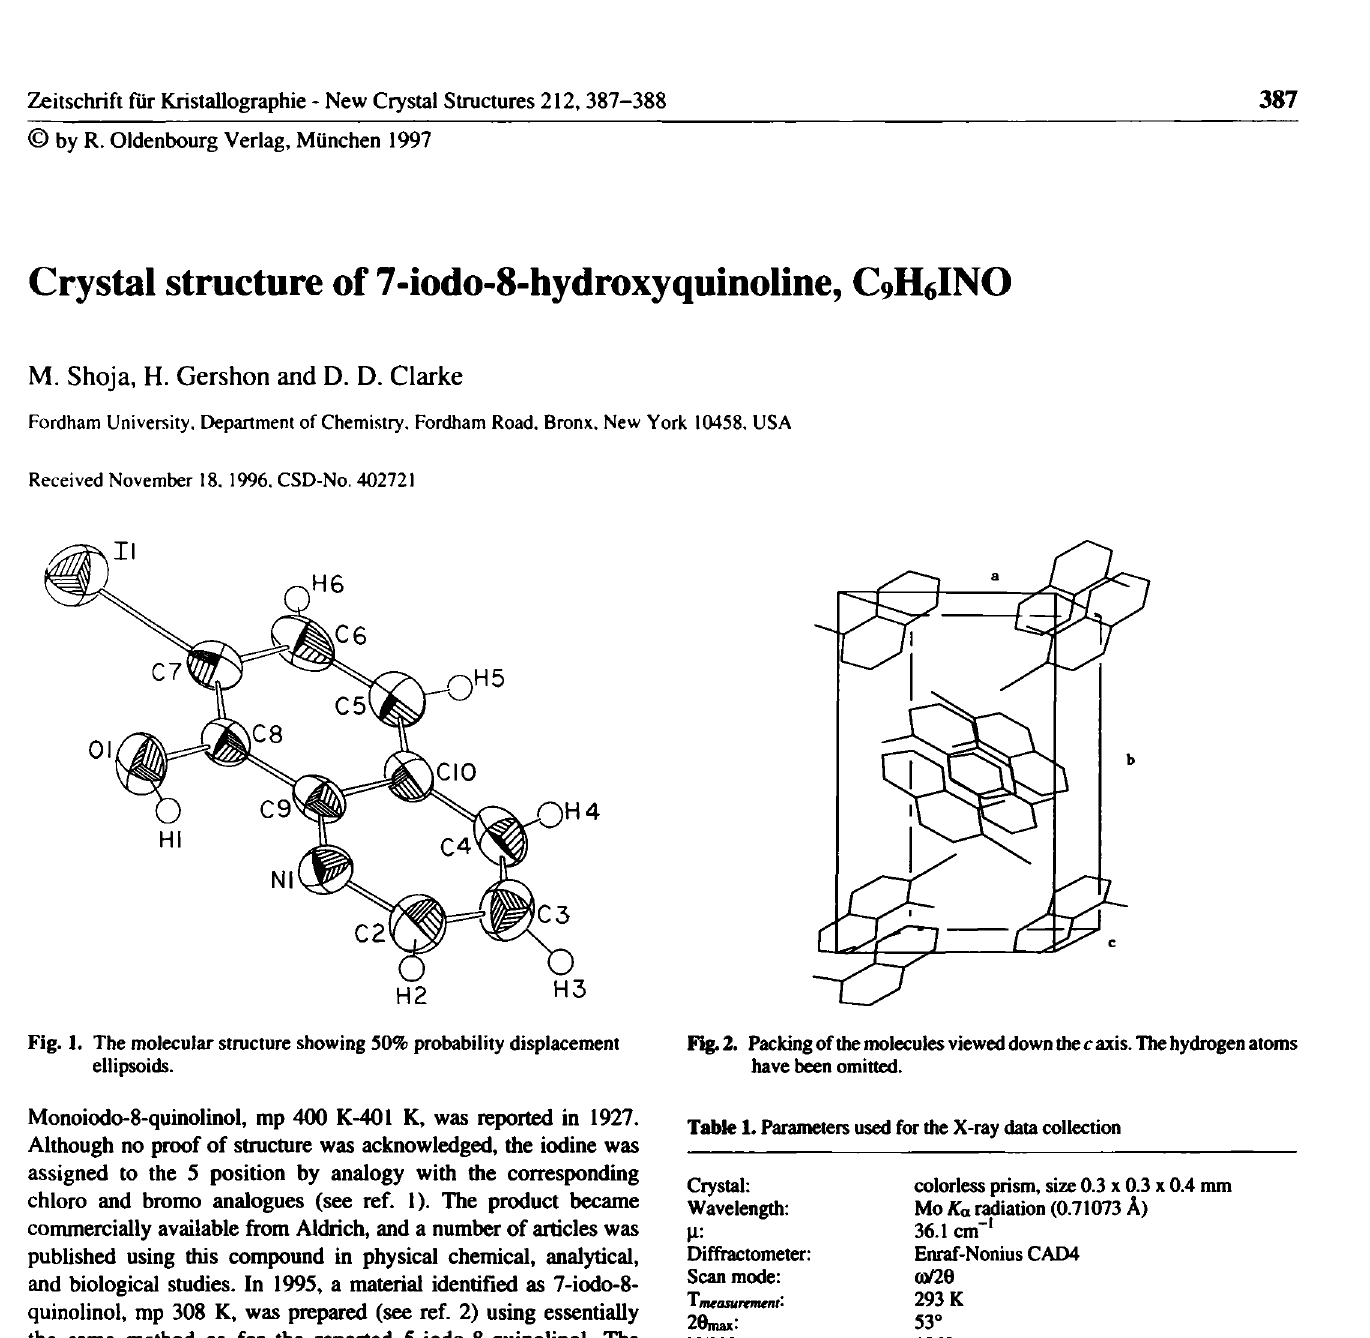
Table 2. Final atomic coordinates and displacement parameters (in Â 2